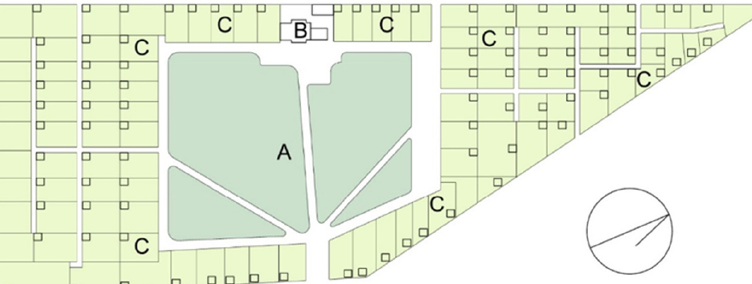
Figure 1. Scheme of the garden colony Schrebergärten in Leipzig (Germany), 1909. A—recreational square, B—allotment board building, C—garden lots, each with a summerhouse (compiled by A. Nowysz, original study, based on local visit).